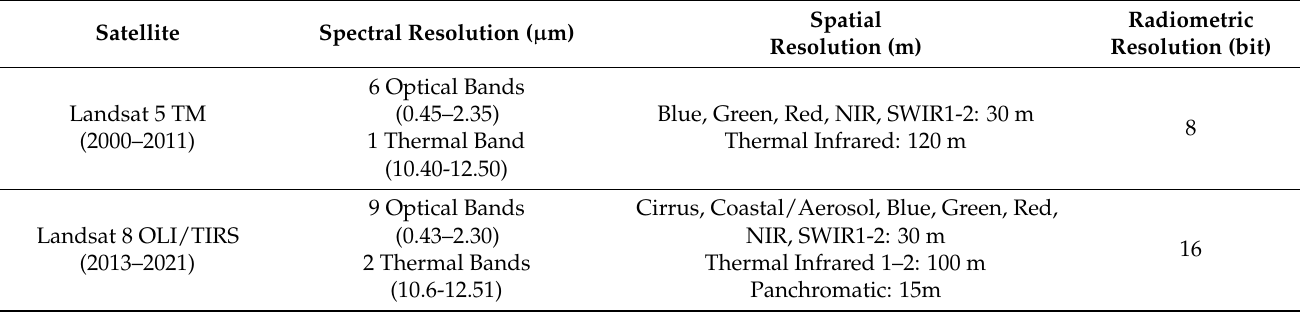
Table 2. Information about used satellite imageries